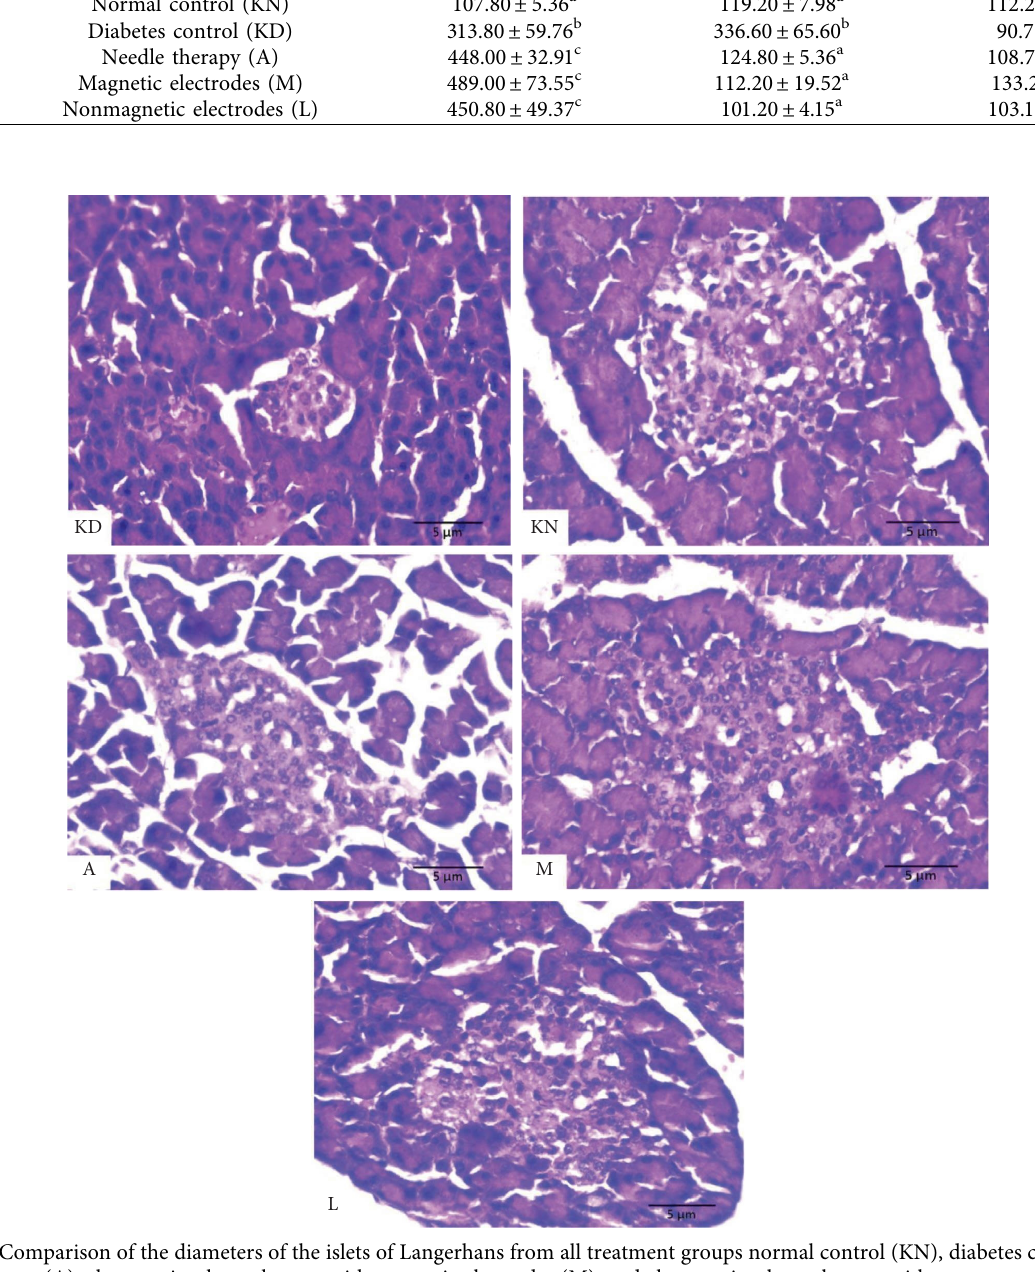
Table 1: Efects of electrostimulation therapy on random blood sugar levels and diameter of the islet of Langerhans in diabetic mice. No.